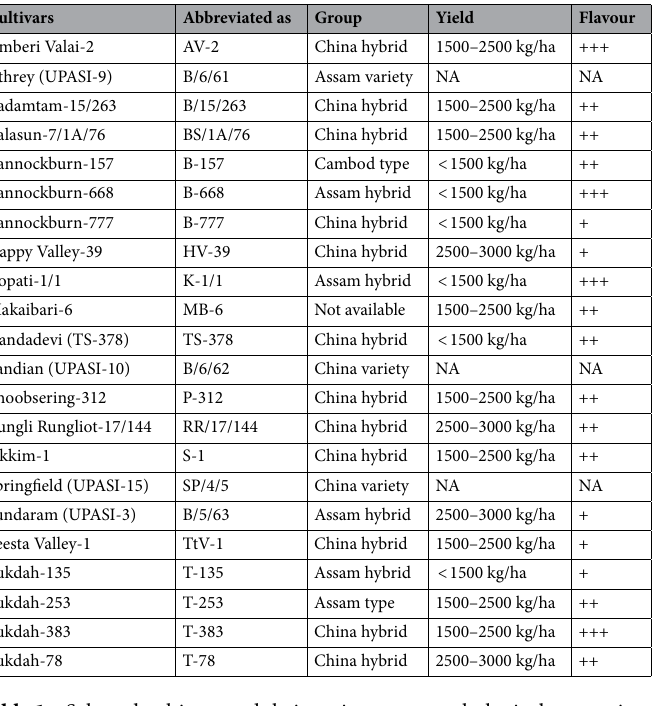
Table 1. Selected cultivars and their main agro-morphological properties. +, ++ and +++ are denoted as average, good, and excellent flavour respectively. NA information not